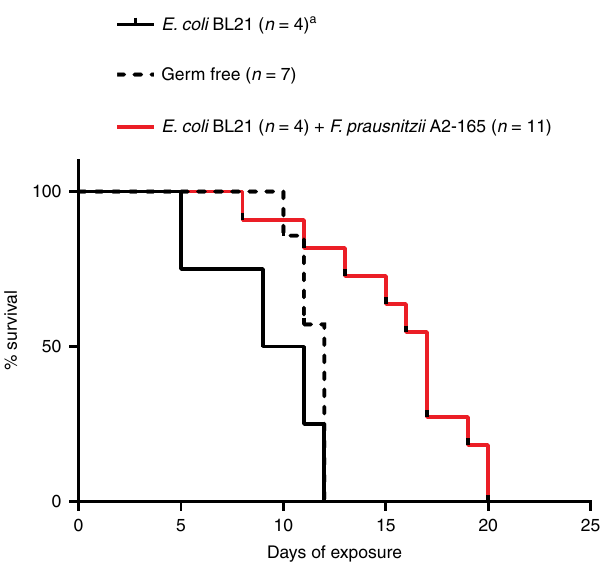
Fig. 6 F. prausnitzii protects against arsenic toxicity. Germ-free, E. coli mono- colonized (one cage of four mice), and E. coli + F. prausnitzii bi-colonized (three replicate cages of 3 or 5 mice each) As3mt-KO mice were exposed to 25 ppm iAs V . Survival was not signi fi cantly different between GF and E.